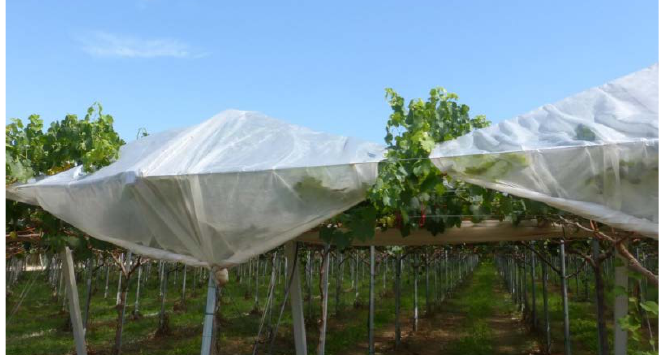
Figure 3. Vineyard after removing the side plastic sheets in order to improve air circulation and reduce overheating of air and vine organs.